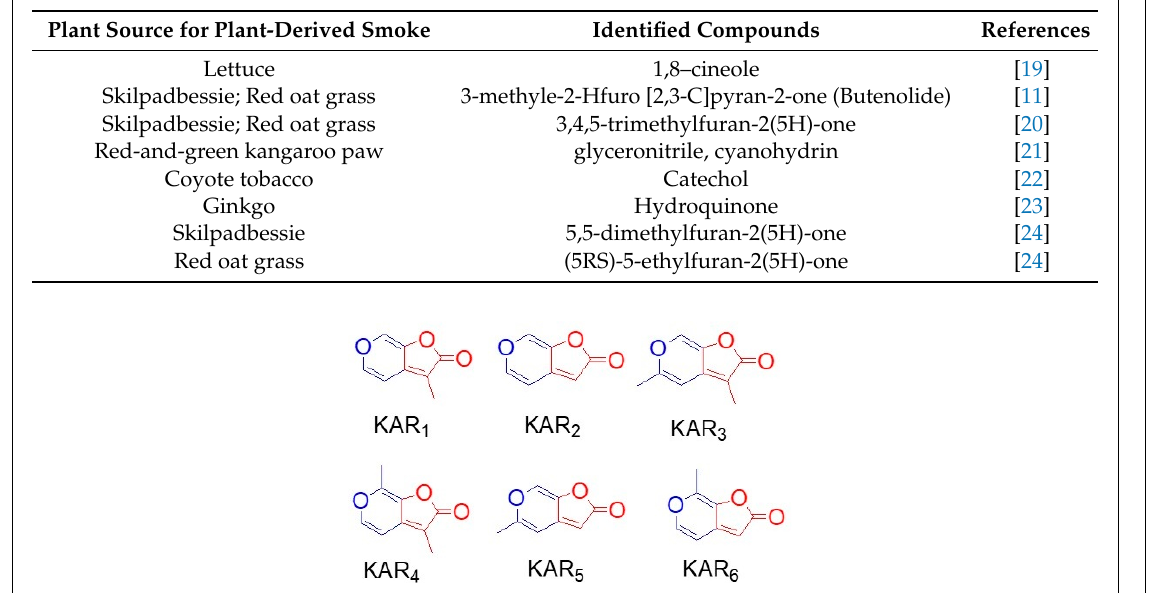
Table 1. A list of di ff erent compounds identified in plant-derived smoke.